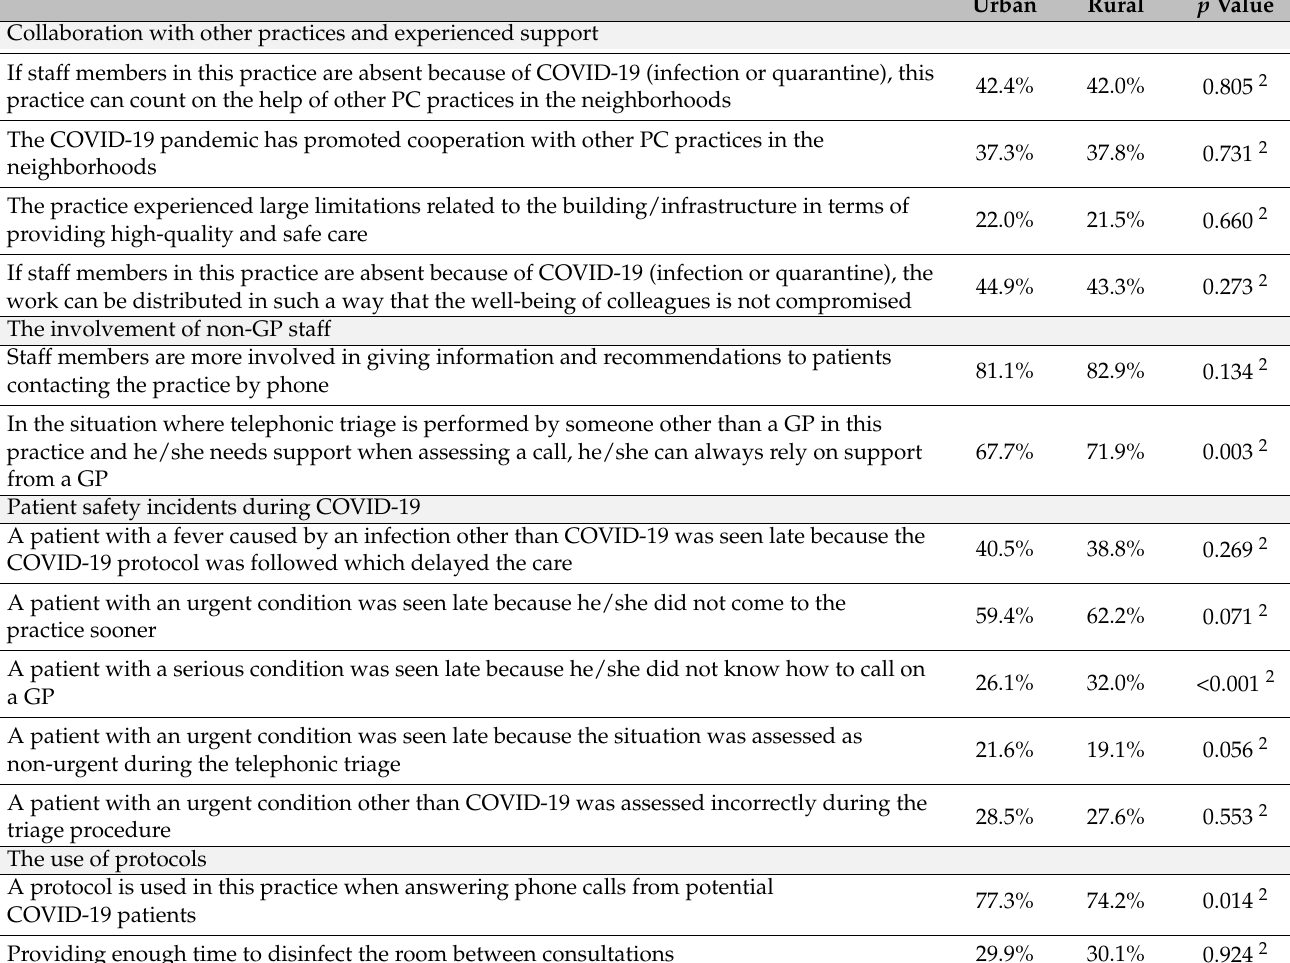
Table 2. Practice organization ( n =